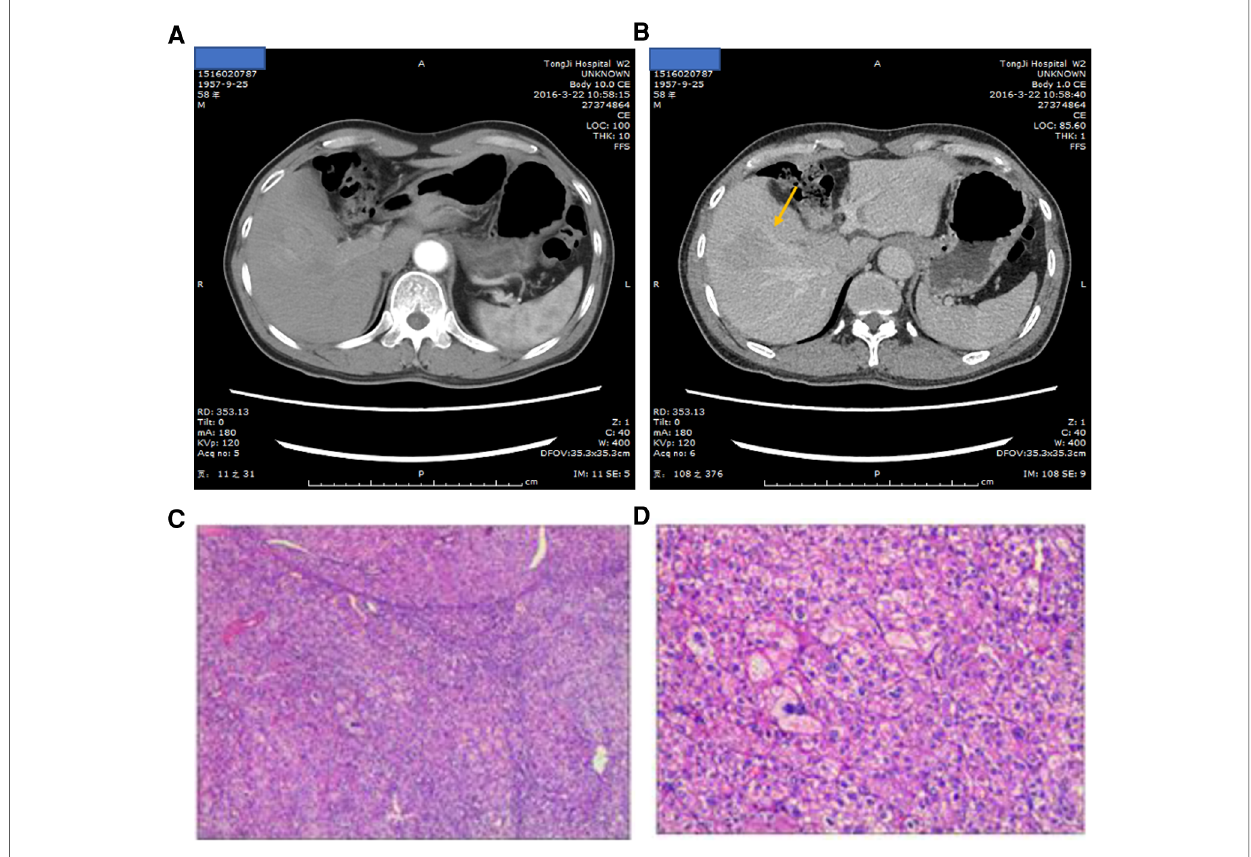
FIGURE 1 ( A ) Arterial phase of the liver-enhanced CT scan showing the tumor lesion in segments 5 and 6. ( B ) Portal venous phase of the liver-enhanced CT scan showing the tumor lesion in segments 5 and 6; the arrow points at the liver lesion. ( C,D ) HE staining of pathological